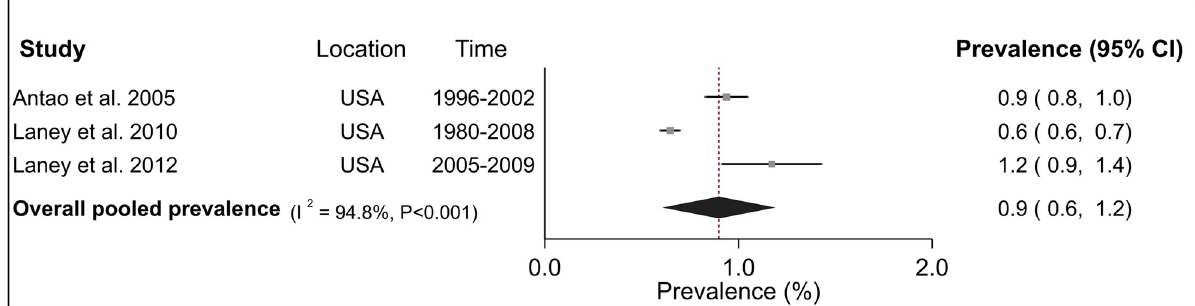
Fig 4. Forest plot from meta-analysis for overall prevalence of advanced coal workers pneumoconiosis in the United States (USA). The red dashed line corresponds to the overall effect size to guide the eye.